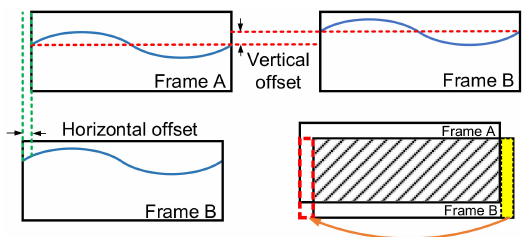
Figure 7. The mosaic principle of unfolded images.